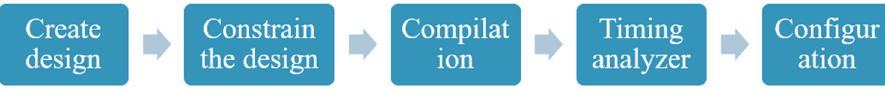
Figure 5. Summary of design and implementation process. Figure 6. FPGA implementation